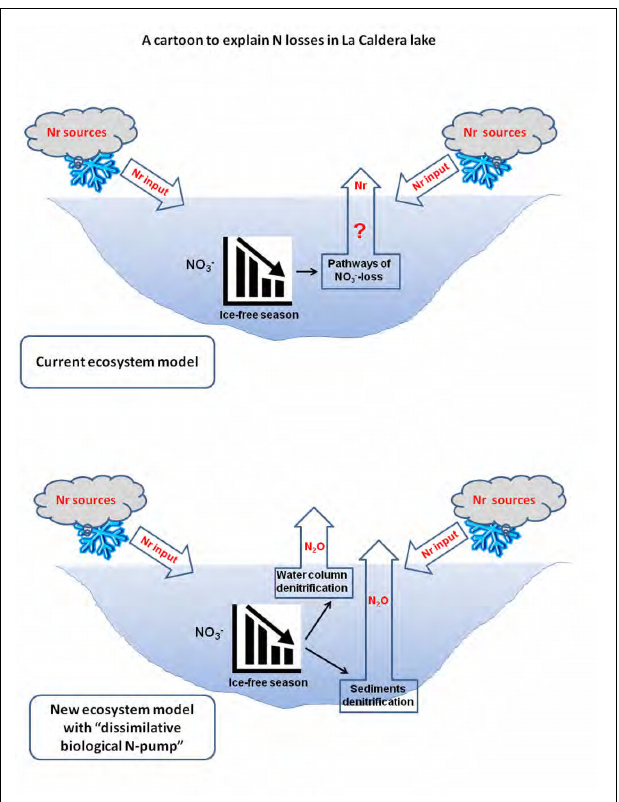
FIGURE 4 | A conceptual model of how a “dissimilative biological N-pump” could explain the seasonal loss of N in La Caldera lake (Sierra Nevada,